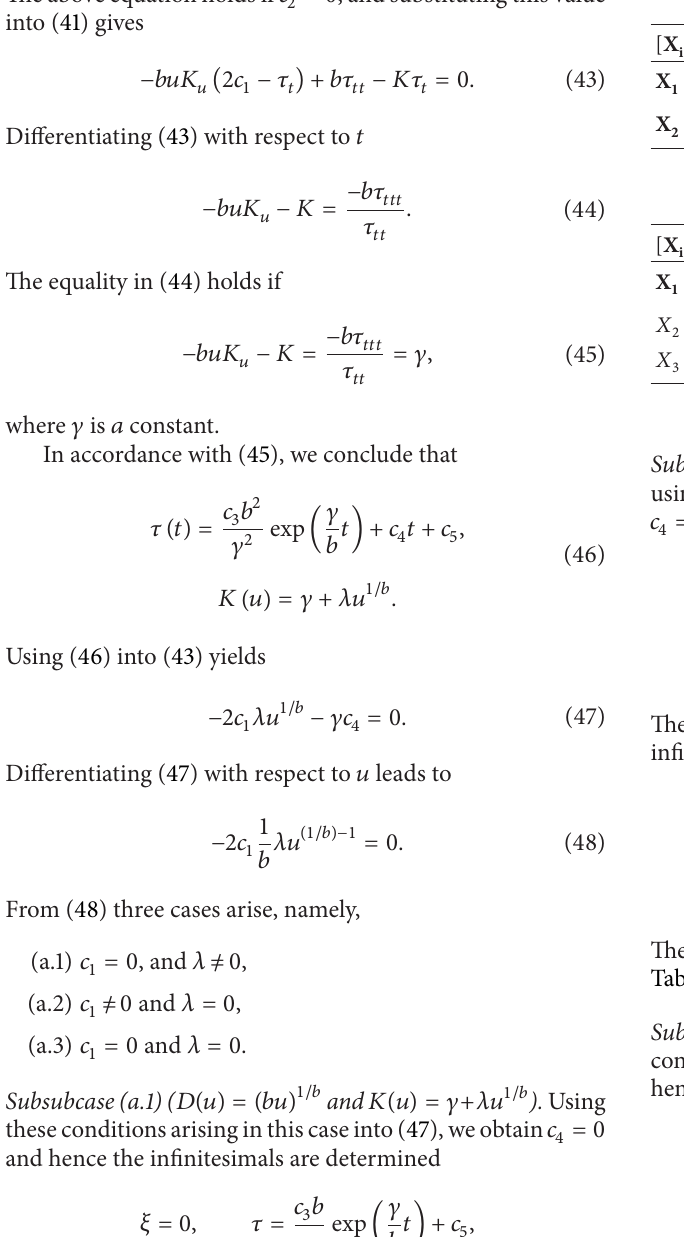
Table 2: Commutator table of the tumor equation.